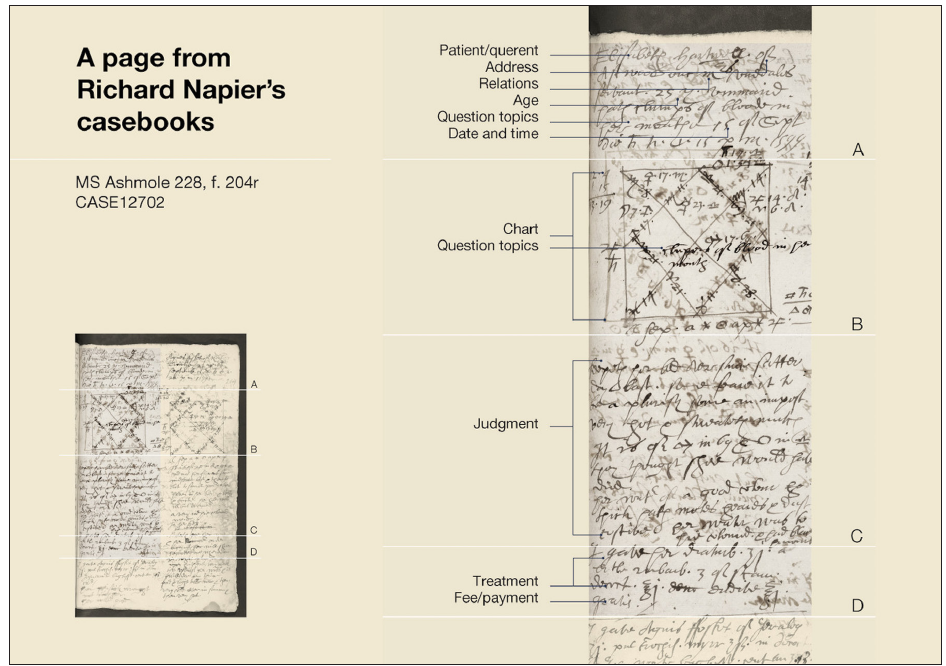
Figure 4: Anatomy of a case, from Lauren Kassell, Michael Hawkins, Robert Ralley, and John Young, “Anatomy of a Case,” A Critical Introduction to the Casebooks of Simon Forman and Richard Napier, 1596–1634